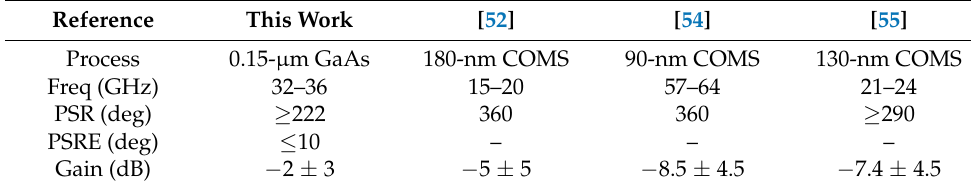
Table 3. Comparison table of phase